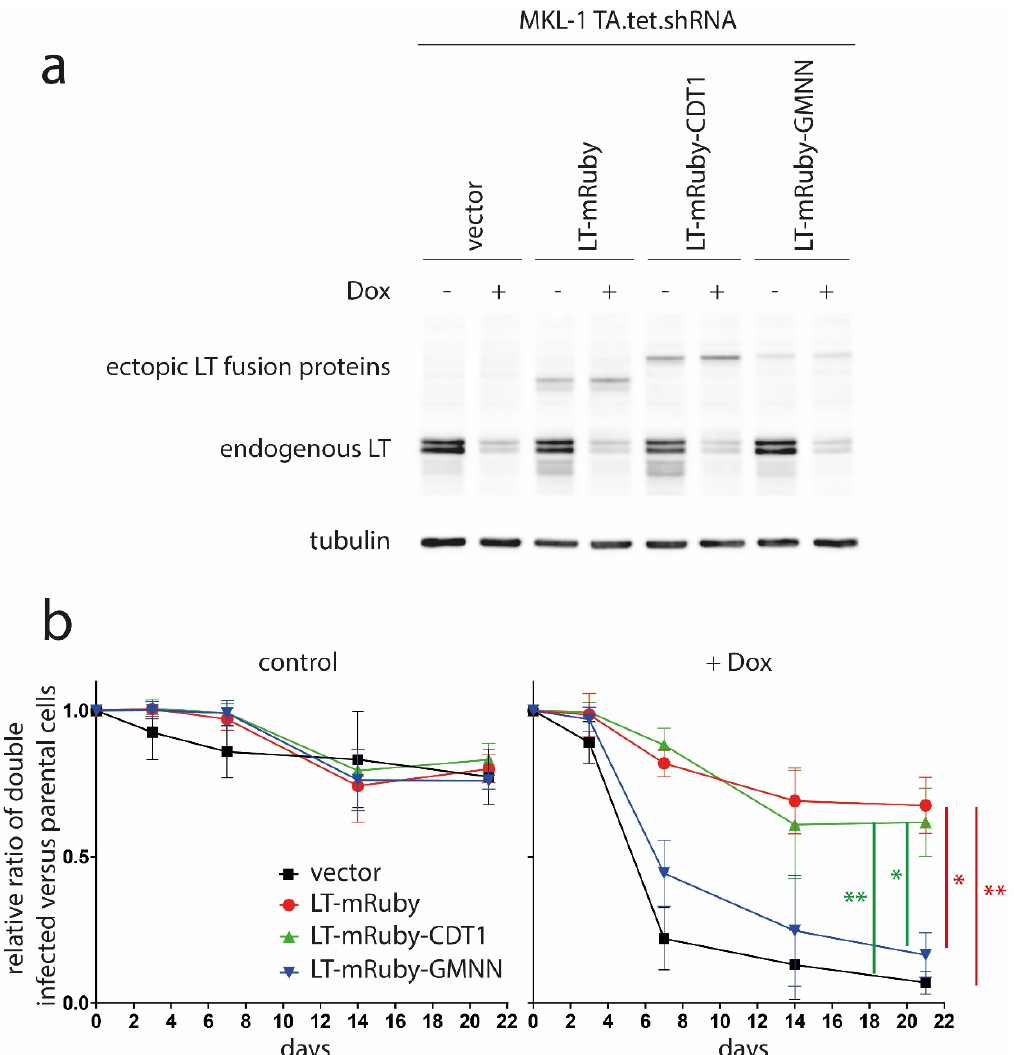
Figure 3. MCPyV-LT present only in G1 is capable of rescuing the growth arrest induced by knockdown of endogenous LT. MKL-1 cells transduced with a vector (TA.shRNA.tet) allowing Dox-inducible expression of a T antigen-targeting shRNA as well as constitutive expression of GFP were additionally transduced with retroviral vectors coding for the indicated LT fusion proteins. Notably, these ectopically-expressed LT variants had been rendered shRNA-insensitive by six silent nucleotide exchanges in the shRNA target sequence. ( a ) Following five days in the absence or presence of Dox (1 μ g/mL) expression of endogenous and ectopic LT were analyzed by immunoblot. ( b ) The ratios of a mixed population of green-fluorescent double infected cells with uninfected, non-fluorescent parental cells were determined over time. Relative ratios based in each case on the measurement of the first time point were calculated and mean values (±SD) of three independent experiments are depicted. Statistical significance was evaluated by calculating the area under the curve (AUC) for each setting of the Dox-treated cells and then comparing the AUC of each group by one-way-ANOVA. Since the group means were significantly different ( p = 0.2204), the Tukey post hoc test was performed to identify significant between-group differences. To this end, the comparison of LT-mRuby/vector, LT-mRuby/LT-mRuby-GMNN, LT-mRuby-CDT1/vector and LT-mRuby-CDT1/LT-mRuby-GMNN were statistically significant (* = adjusted p < 0.05; ** = adjusted p < 0.01). Supplementary Materials: The following are available online at www.mdpi.com/xxx/s1. Figure S1: The weaker band observed for LT-mRuby-GMNN (Figure 3) is not due to reduced transcription from the retroviral vector. Figure S2: LT-mRuby-CDT1 rescues reduced DNA synthesis upon knockdown of endogenous MCPyV-LT as efficient as LT-mRuby. Figure S3: LT-mRuby-CDT1 supports RB1 target gene expression as efficient as LT- mRuby. Table S1: Primers used for real time PCR.